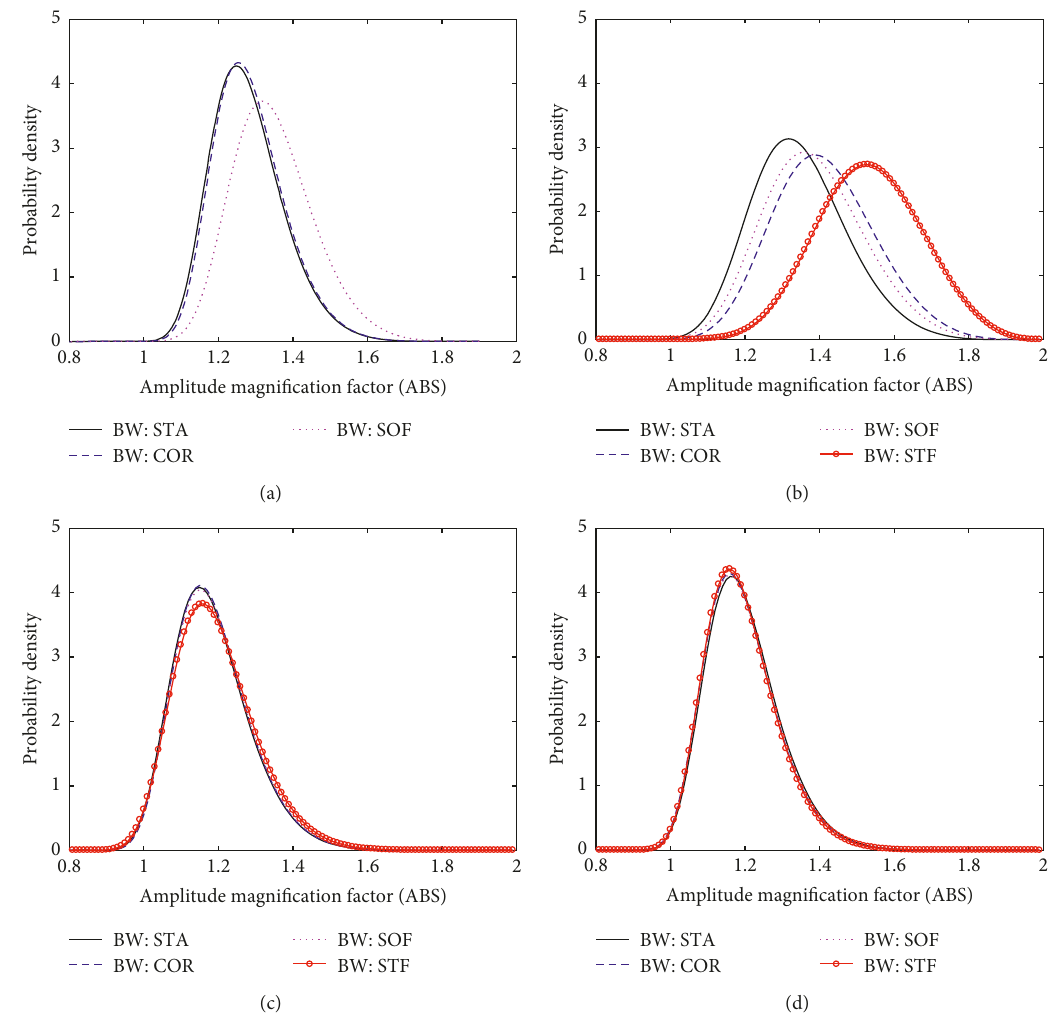
Figure 16: Probability densities versus absolute AMF obtained by Monte Carlo simulation of 2000 mistuning patterns generated by uniform distribution of mean 0 and standard deviation 2.0% under the action of (a) 2EO, (b) 3EO, (c) 4EO, and (d) 5EO backward traveling wave excitations.